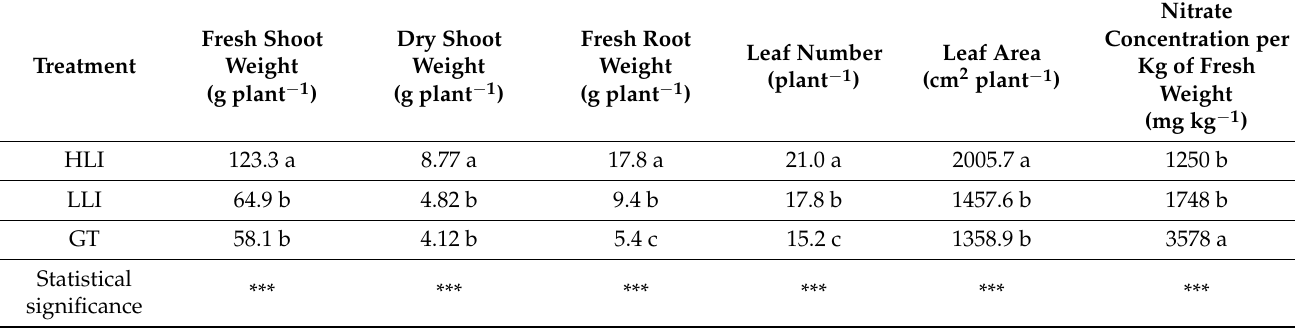
Table 2. Effect of different light intensities and hydroponic cropping system on growth and development of lettuce ‘Glory’ grown in a vertical farming system and in a glasshouse during the winter. HLI, High light intensity; LLI, Low light intensity; GT, Glasshouse treatment.